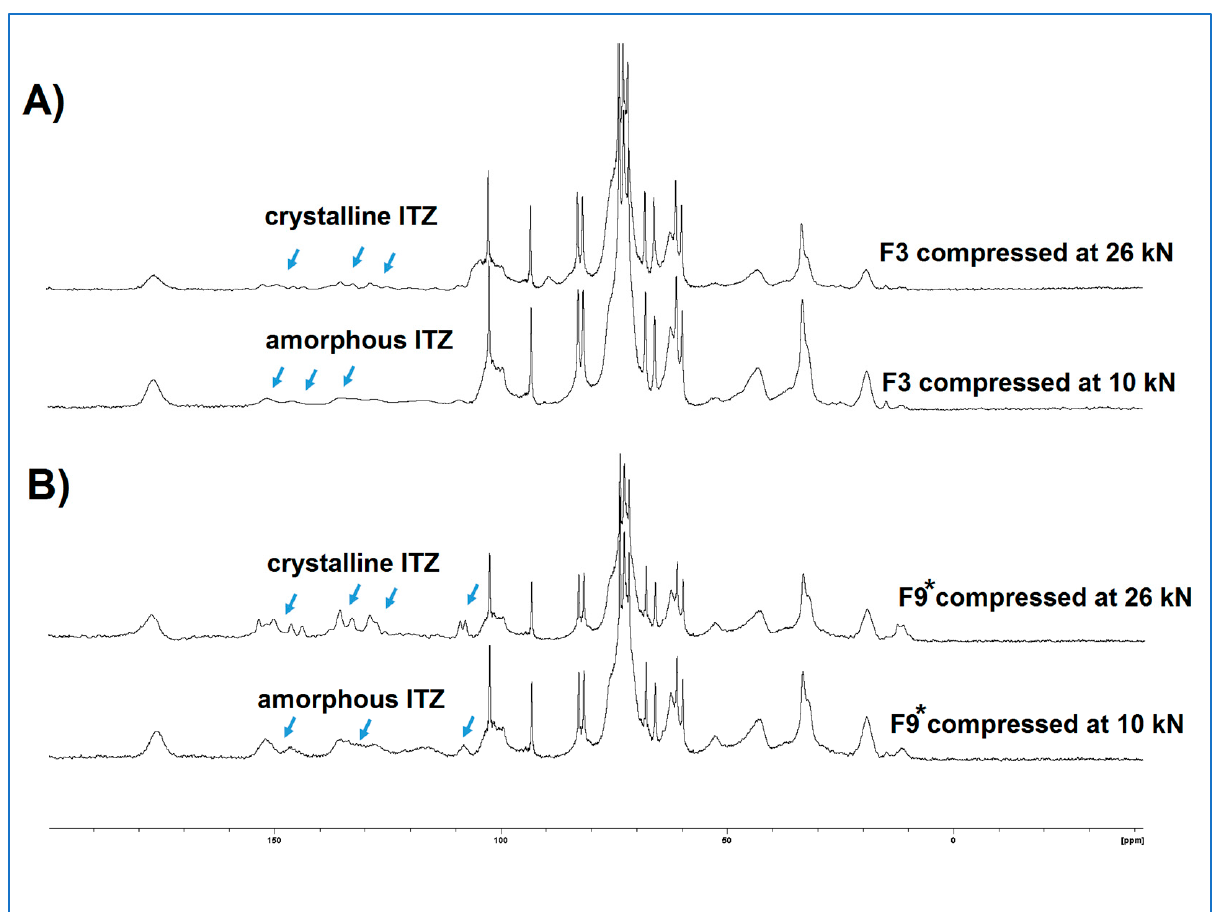
Figure 12. Comparison of 13 C CP/MAS NMR spectra of tablets compressed at 10 kN and 26 kN for ( A ) F3 tablets (with the lowest itraconazole content) and ( B ) F9* tablets (with the highest itraconazole content). (ITZ = itraconazole).